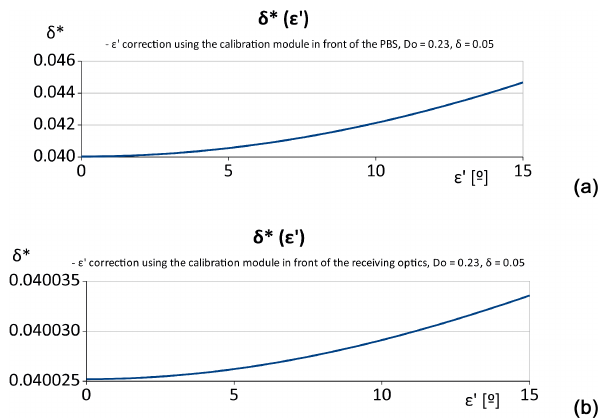
Figure 6. Numerical simulation: (a) calibrated signal ratio vs. ε (cid:48) when using the α correction module in front of the PBS (b) mea- sured depolarization ratio vs. ε (cid:48) when using the α correction module in front of the receiving